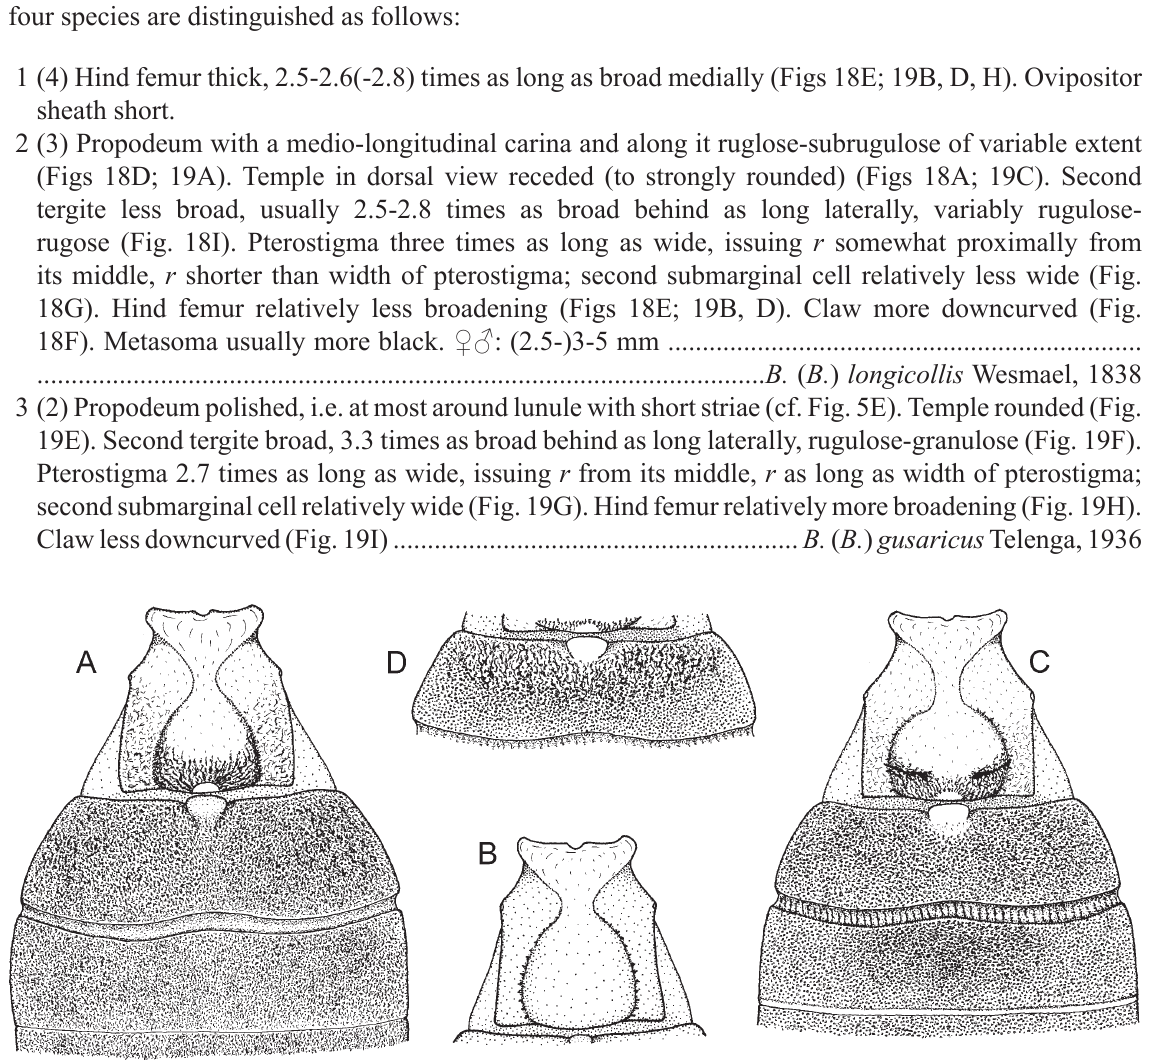
Fig. 26. — A . Bracon ( Bracon ) variegator Spinola, 1808, ♀. tergites 1-3. — B . Bracon ( Bracon